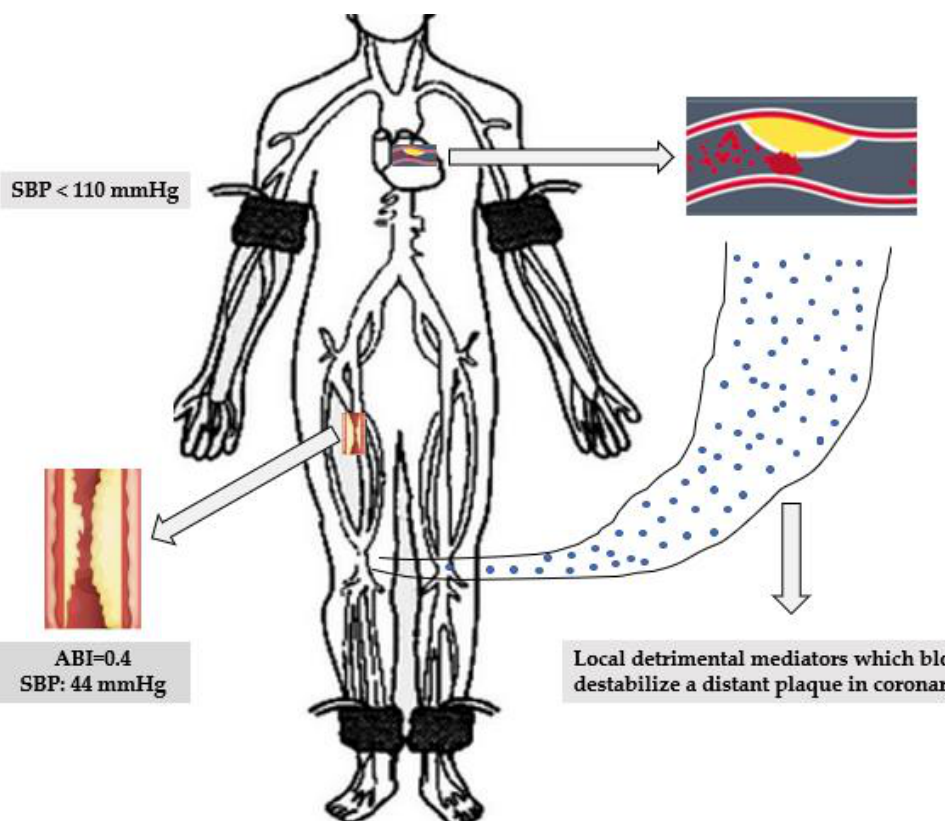
Figure 2. Proposed mechanism of destabilization of a coronary plaque by distal ischemia. A patient with PAD and ABI of 0.4 may have SBP leg lower of 44 mm Hg to a brachial SBP of 110 mm Hg. Local detrimental mediators, free oxygen radicals or inflammatory mediators bloodborne can produce a myocardial event by destabilize a coronary plaque. Abbreviations: ABI, ankle brachial index; SBP, systolic blood pressure.